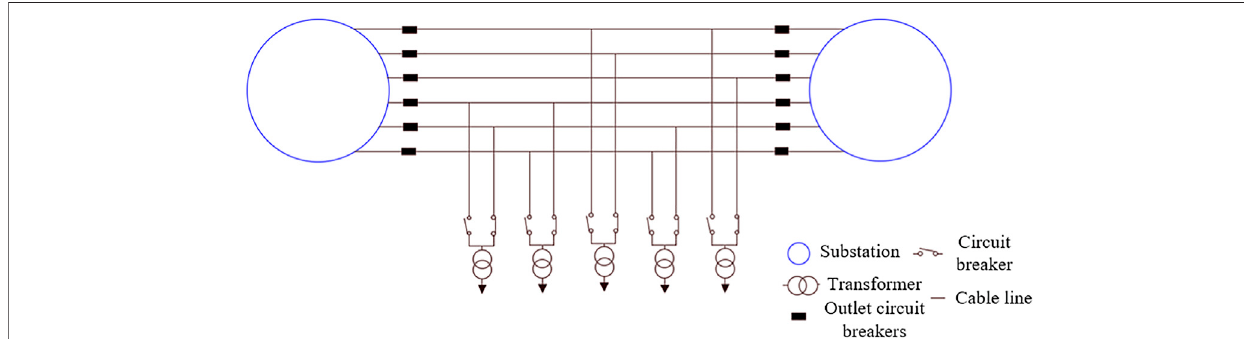
FIGURE 2 | Schematic diagram of 20 kV three-ring network in Paris city.